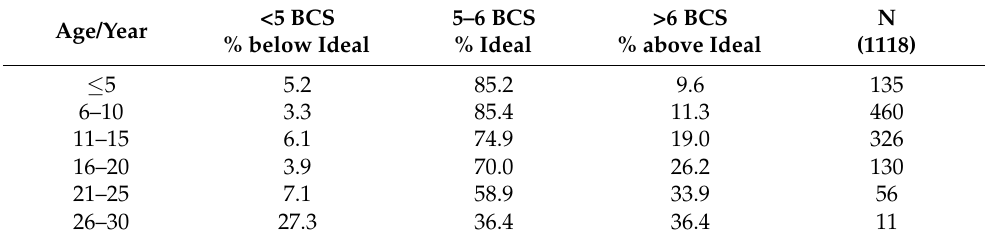
Table 7. Distribution of below ideal, ideal, and above ideal BCS for horses in relation to age.